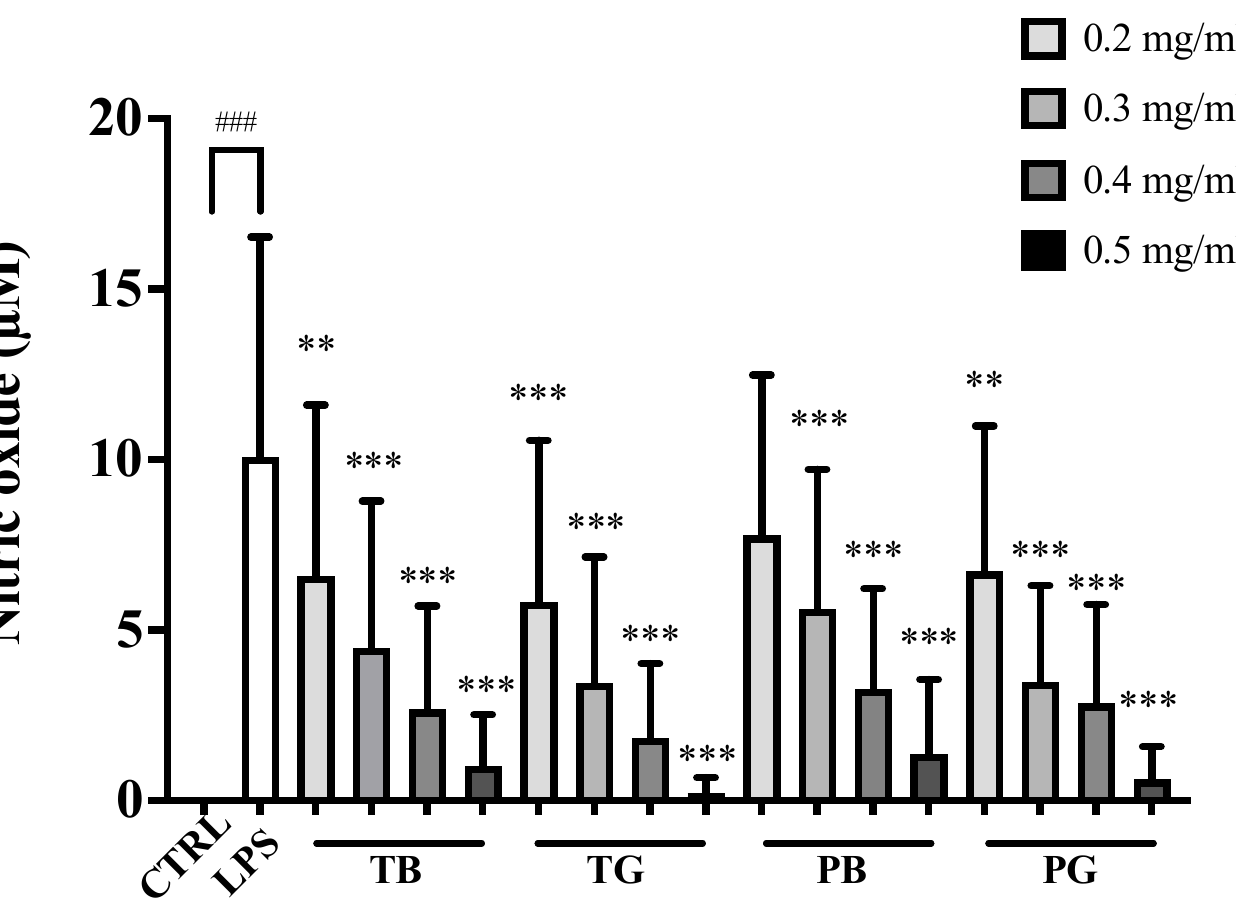
Figure 5. In addition, the inhibition of four tea extracts on NO in LPS-stimulated cells showed that green tea was better than black tea, particularly in the prophylactic model. RAW264.7 cells showed that green tea was better than black tea, particularly in the Current data were in accordance with the above results of antioxidant activity. These prophylactic model. Current data were in accordance with the above results of antioxidant findings suggested that purple shoot teas could act as prophylactics by increasing ROS activity. These findings suggested that purple shoot teas could act as prophylactics by elimination in the LPS-stimulated RAW 264.7 cells, especially for PG. increasing ROS elimination in the LPS-stimulated RAW 264.7 cells, especially for PG.